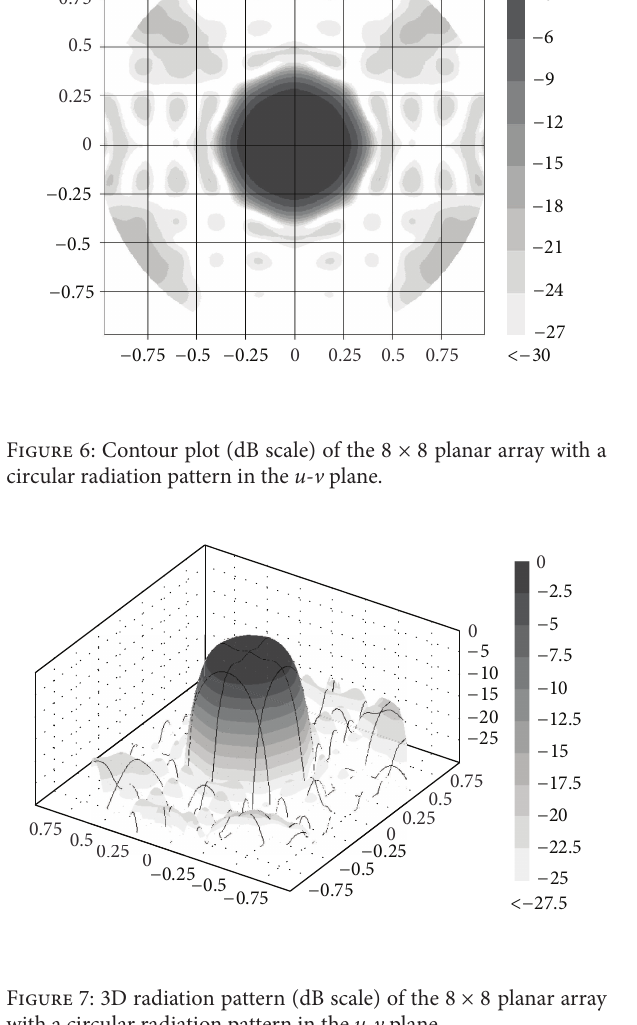
Figure 7: 3D radiation pattern (dB scale) of the 8 × 8 planar array with a circular radiation pattern in the u - v plane.